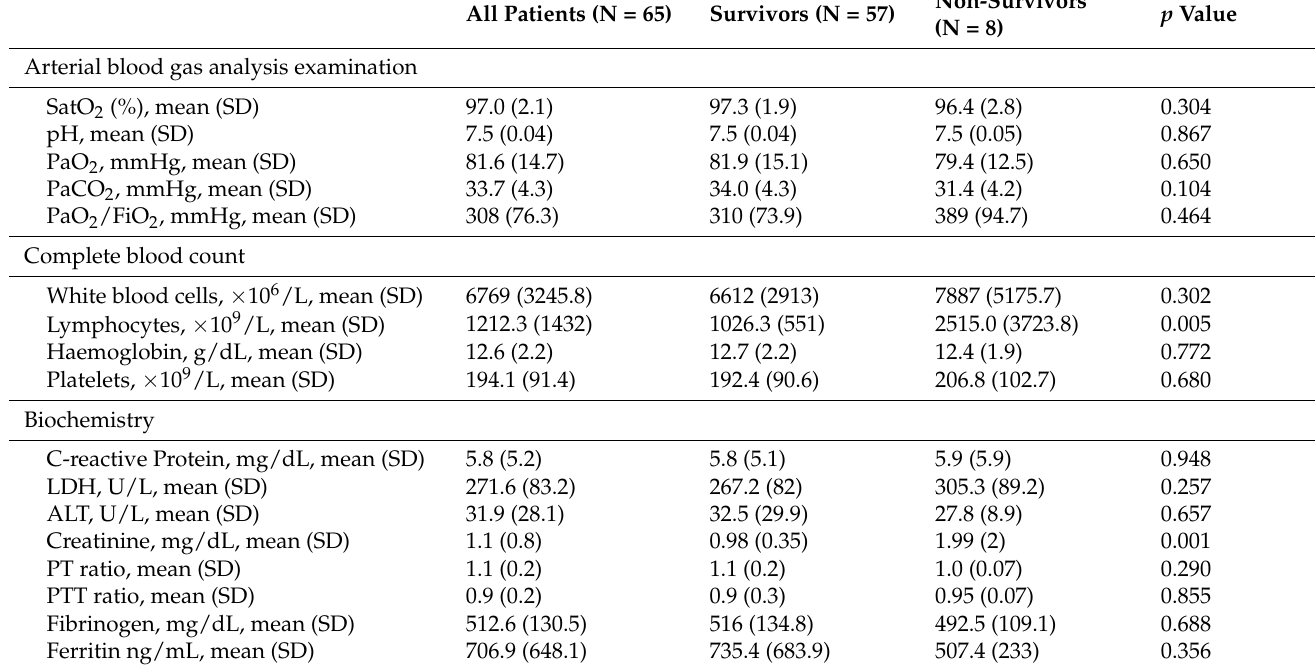
Table 3. Laboratory findings at